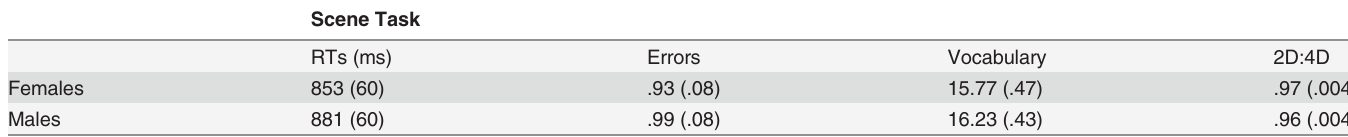
Table 1. Summary of mean scores for the scene task, vocabulary test and 2D:4D ratios. Standard errors are shown in